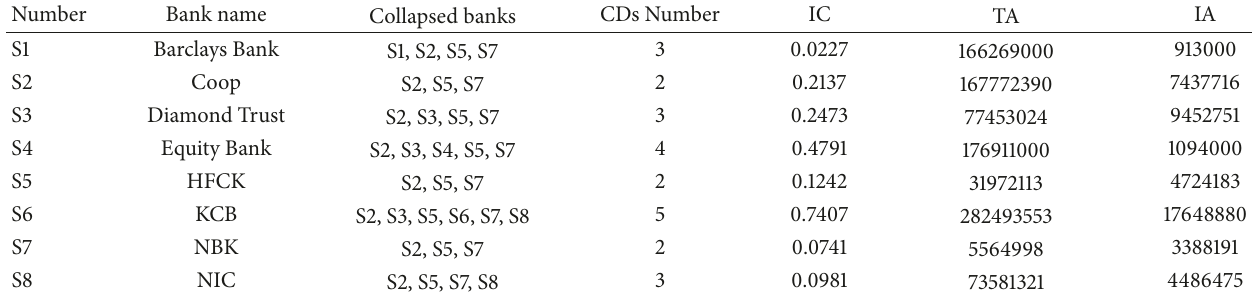
Table 3: Results of stress test in 2011.